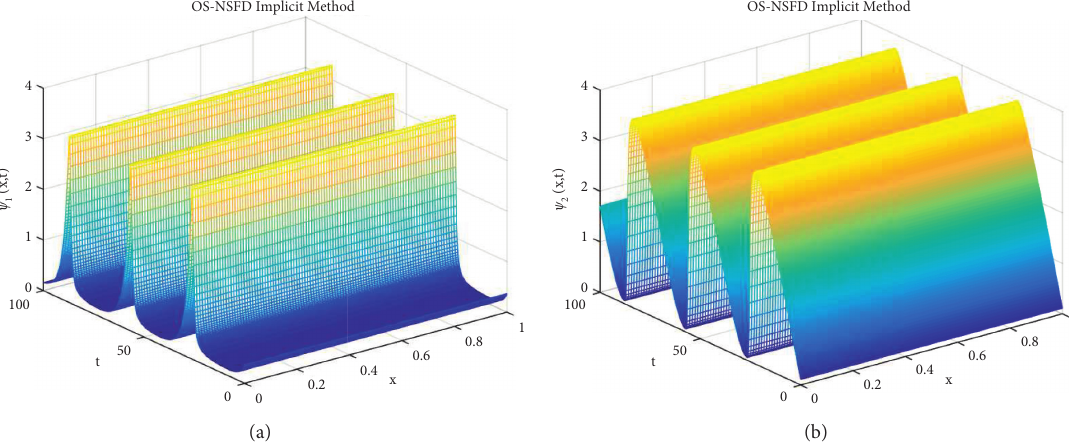
Figure 19: Mesh graphs of ψ Mesh graph of ψ